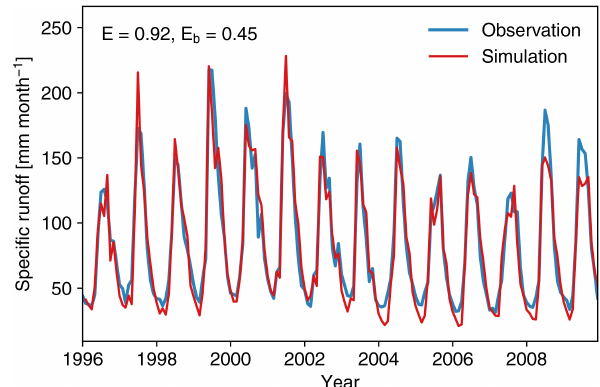
Figure 2. Specific runoff hydrographs for observed and modelled runoff at Kirchbichl gauging station and the corresponding perfor- mance measures E (Nash–Sutcliffe model efficiency, NSE) and E b (benchmark